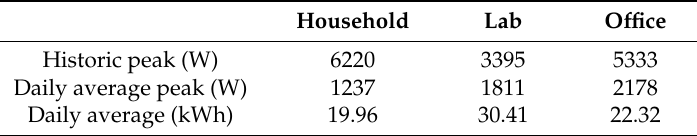
Figure 5. Three standard load profiles. Table 3. The statistical data of load profiles [39].